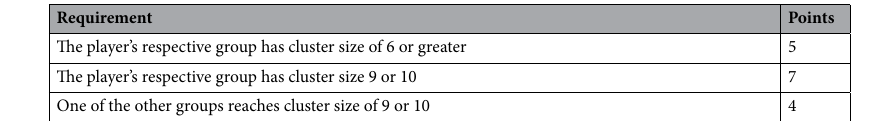
Table 1. The rewarding scheme applied in the experiment. The players obtained points according to the requirements in the table and lost the respective amount of points if the requirement was no longer satisfied. With this scheme the maximum amount of points in a single game was 20 29 .